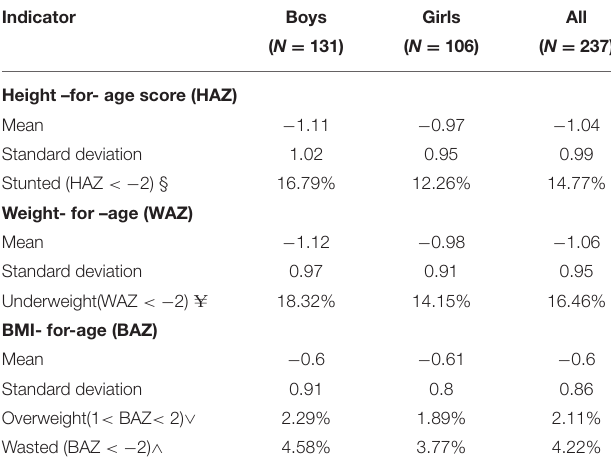
TABLE 2 | Anthropometric indicators of Malnutrition for children 5–7 years in Msambweni, Kenya ( n = 237). Indicator Boys Girls